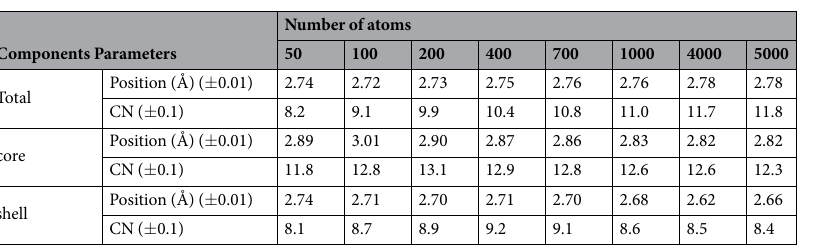
Table 1. The position and average coordination number of the first peak in g(r) for Cu 64 Zr 36 SSAPs total sample, and core and shell